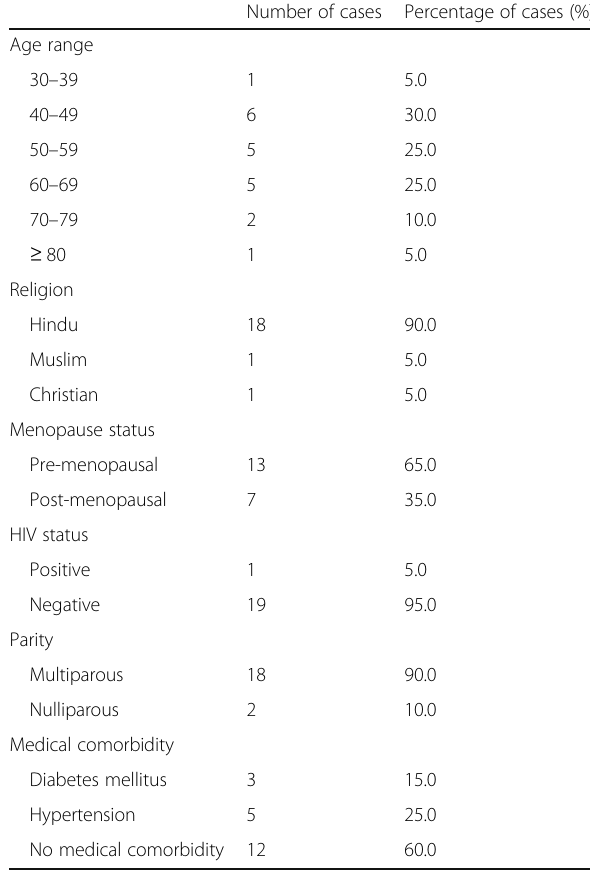
Table 1 Demographic and clinical profiles of vulvar cancer patients Number of cases Percentage of cases